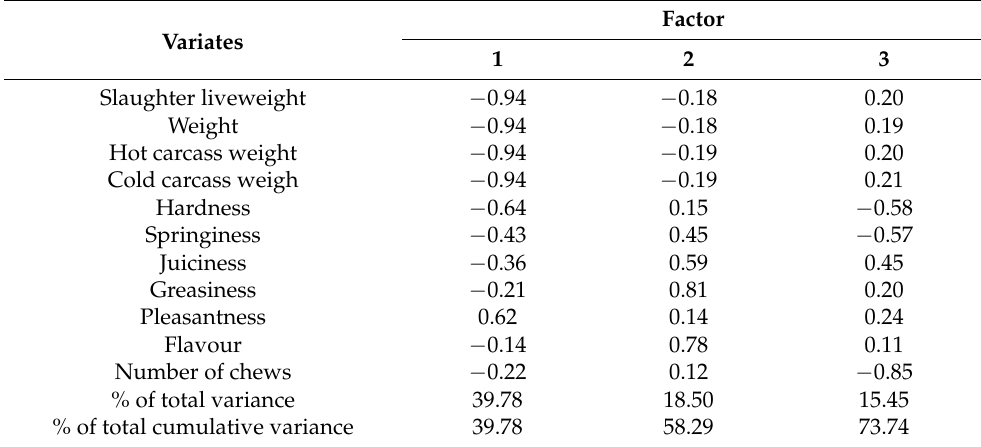
Table 4. PCA results for the first four principal components of zootechnical and sensory parameters in Rubia de El Molar suckling lambs’ meat.